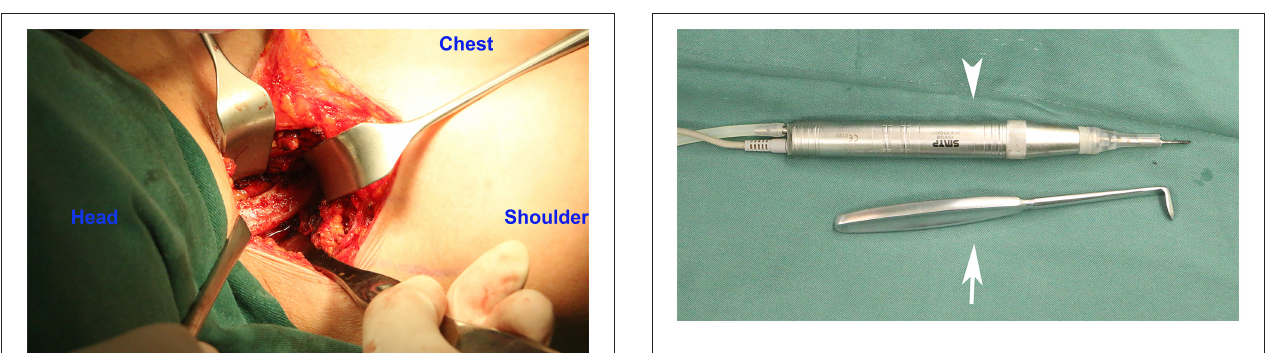
FIGURE 2 | Image of the piezoelectric device and modified periosteal elevator used during the removal of the first rib. The piezo surgery medical device with a slender head (represented by an arrowhead) is shown here. The modified periosteal elevator (represented by a white arrow) was used for blunt dissections. This provides a protective edge to minimize injuries to neurovascular structures surrounding the first rib.